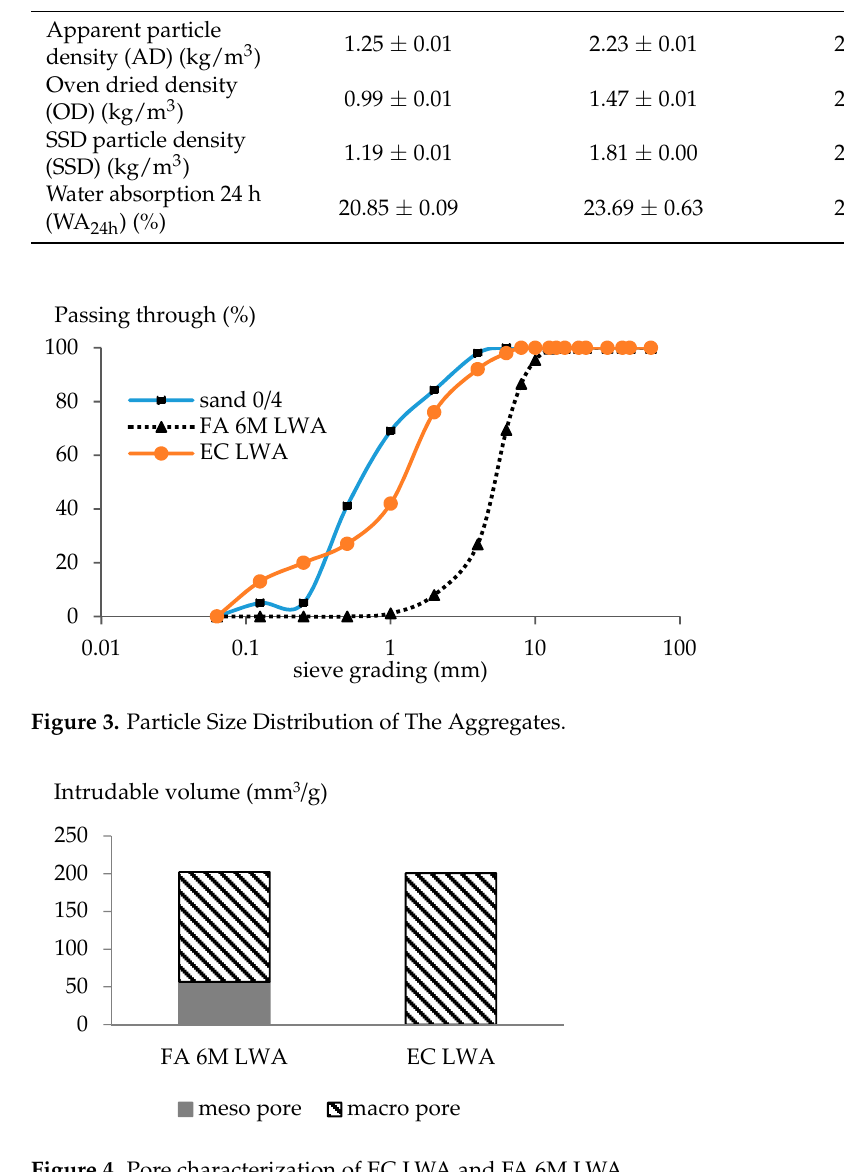
Figure 4. Pore characterization of EC LWA and FA 6M LWA .